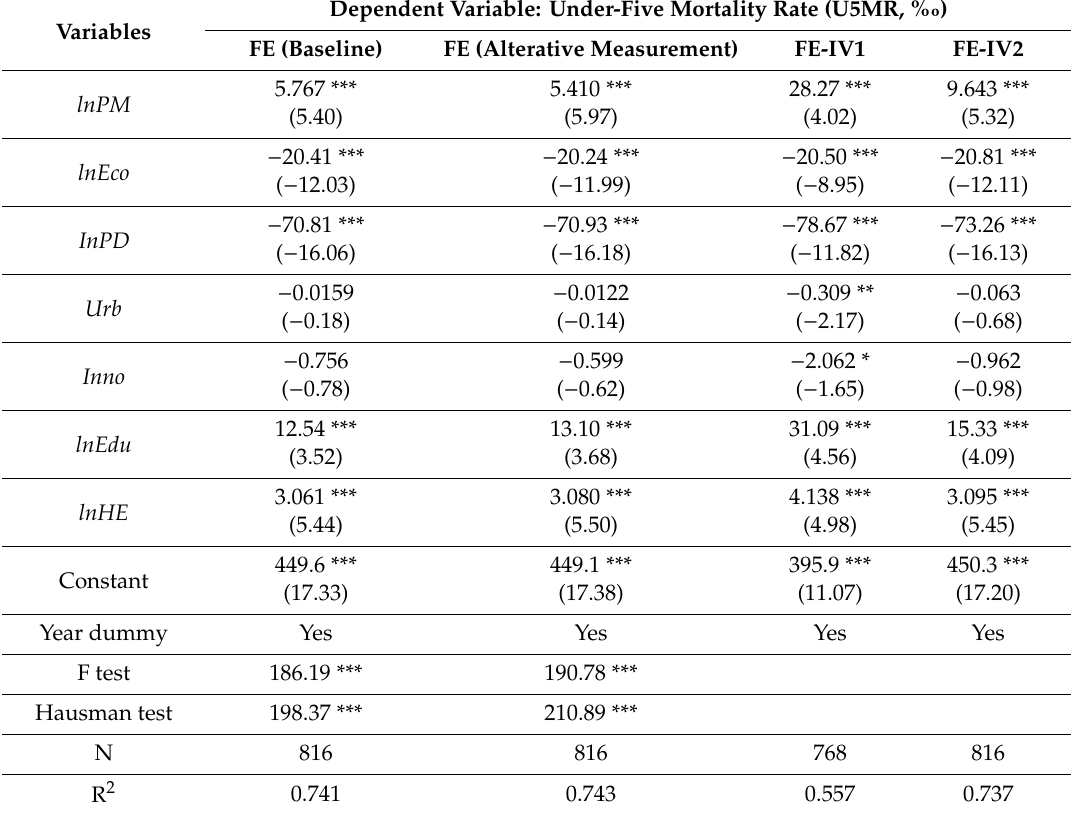
Table 7. Estimation result of economies in transition and developing economies.